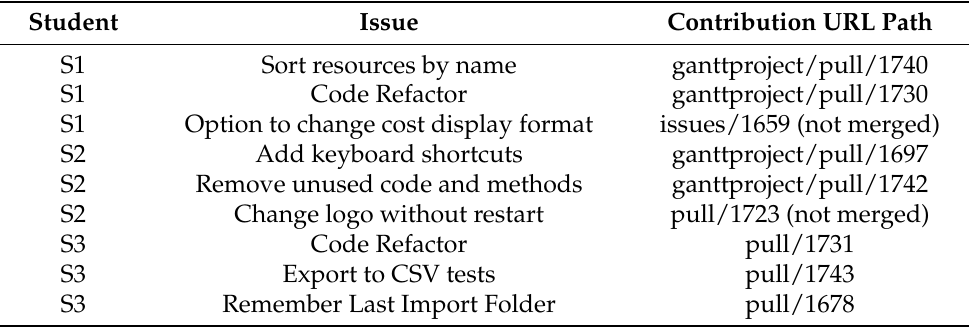
Table 1. Students’ contributions to GanttProject. Base URL: https://github.com/bardsoftware/ (accessed on 14 May